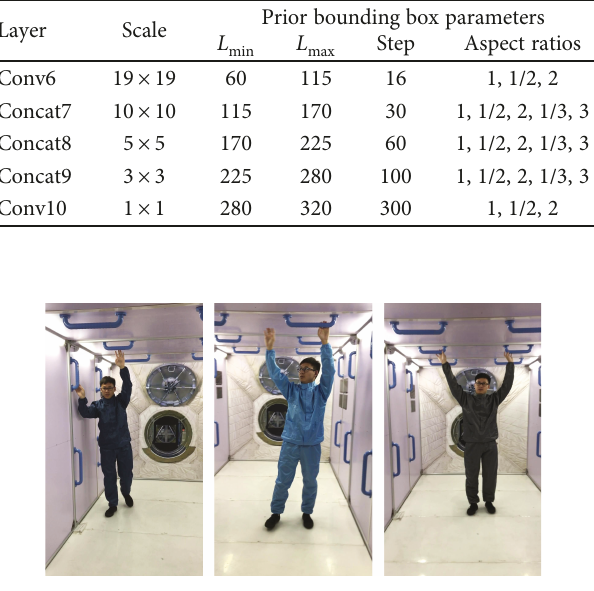
Figure 7: Volunteers in three di ff erent kinds of